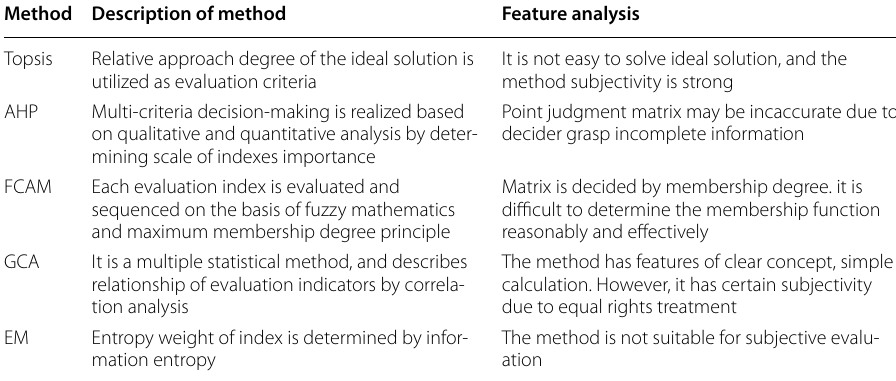
Table 1 Comparative analysis of comprehensive evaluation method Method Description of method Feature